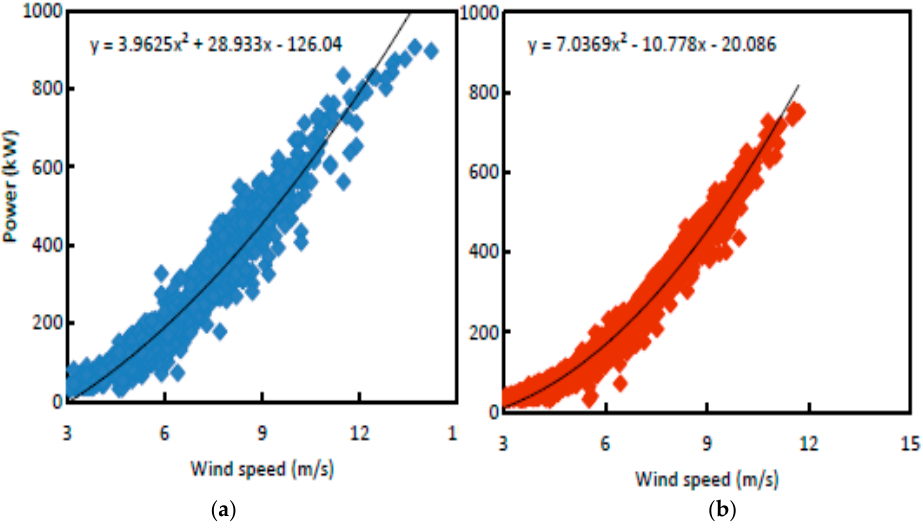
Figure 4. Dataset B observed wind speed and wind power pairs (after filtering) for Nordex N50-800 kW wind turbine in ( a ) winter and ( b ) summer.